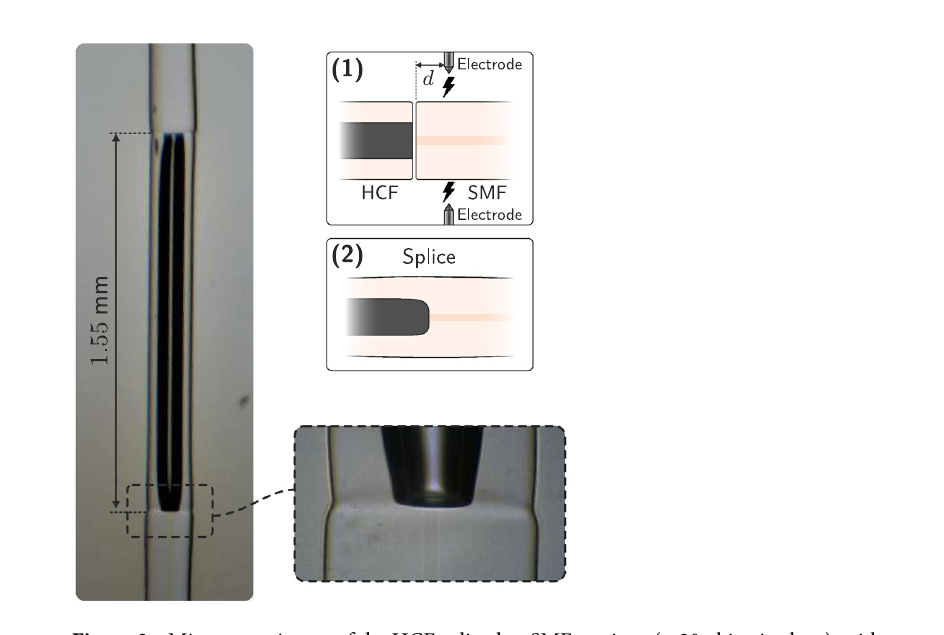
Figure 2. Microscope image of the HCF spliced to SMF sections (× 20 objective lens), with a zoom of the splice section (× 50 objective lens). A schematic of the HCF-SMF splice process is also